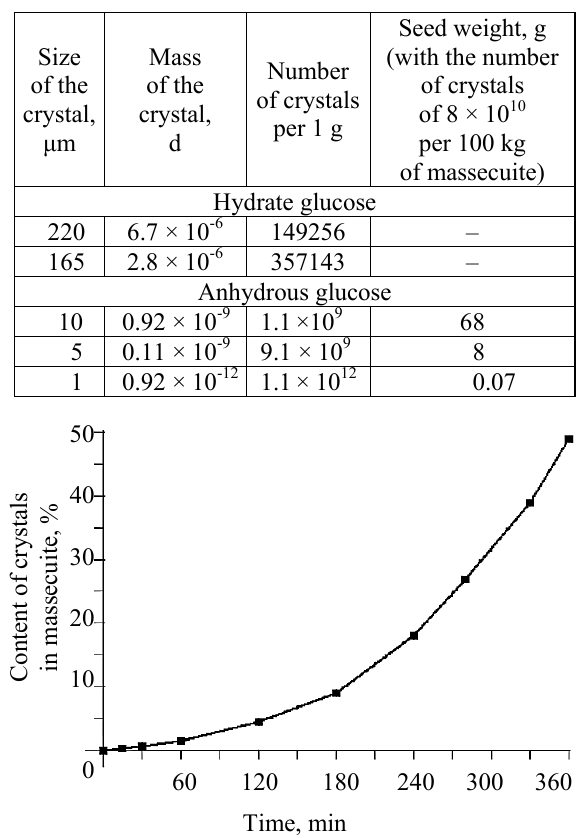
Table 1. Characteristics of seed crystals